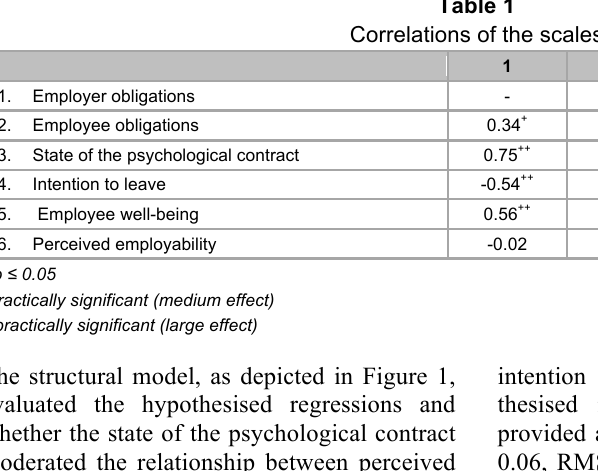
Correlations of the